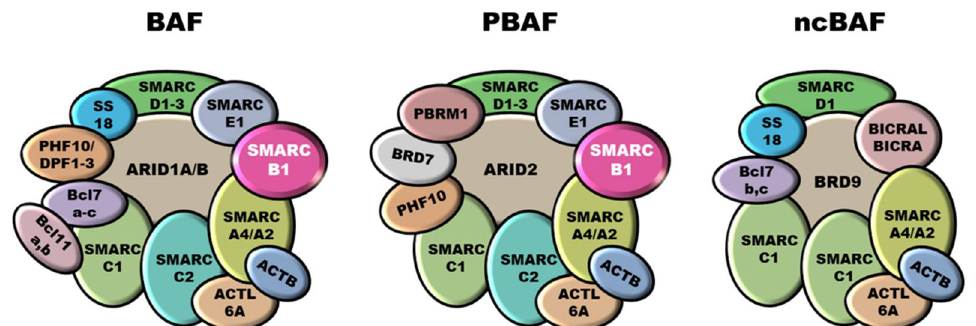
Figure 1. SWI/SNF chromatin remodeling complexes. SWI/SNF complexes are classified into three subgroups: canonical BAF (cBAF), polybromo-associated BAF (PBAF), and non-canonical BAF (ncBAF). SMARCB1 participates into cBAF and PBAF complexes whilst is not included into the ncBAF ones.